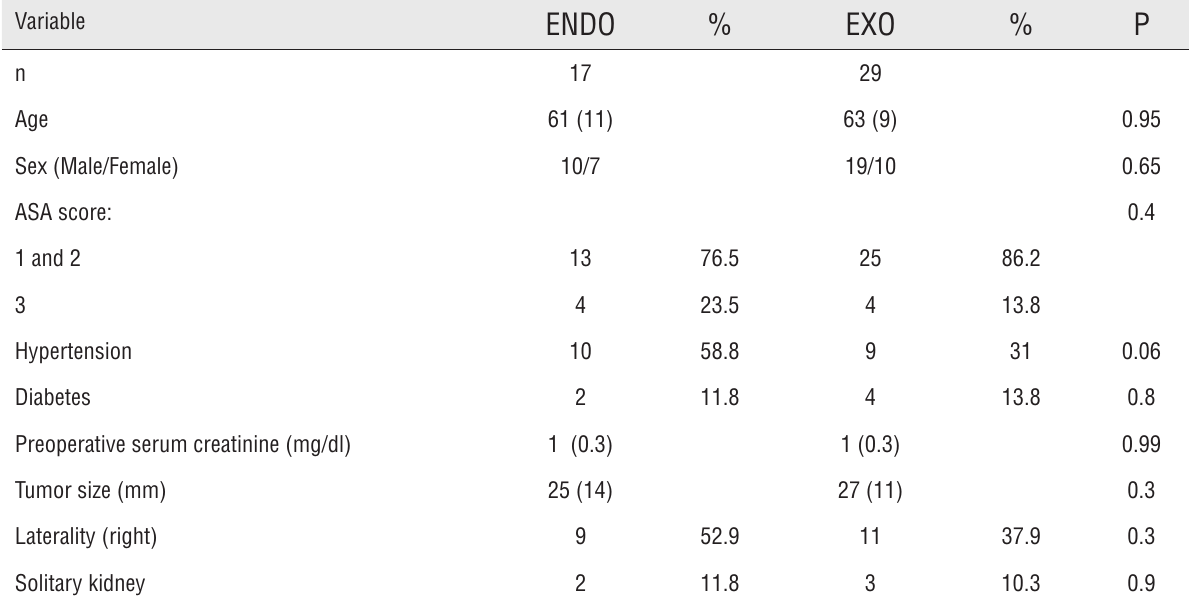
Table 1 - Demographic and clinical characteristics of the patients who underwent open partial nephrectomy for entirely endophytic or exophytic renal